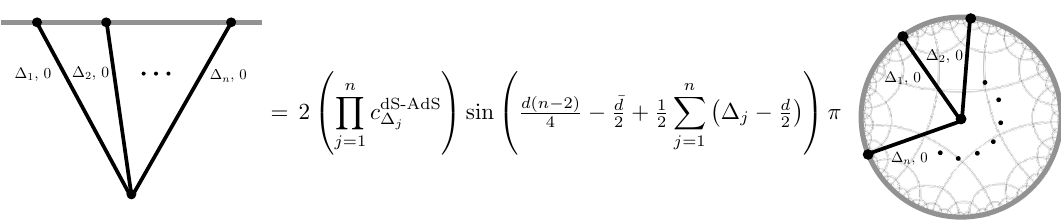
Figure 13. At higher-points, the sinusoidal factor relating the diagrams in dS and EAdS depends on ¯ d , which is sensitive to the number of derivatives in the corresponding vertex. As we will see in the next section, it also depends on the spin of the